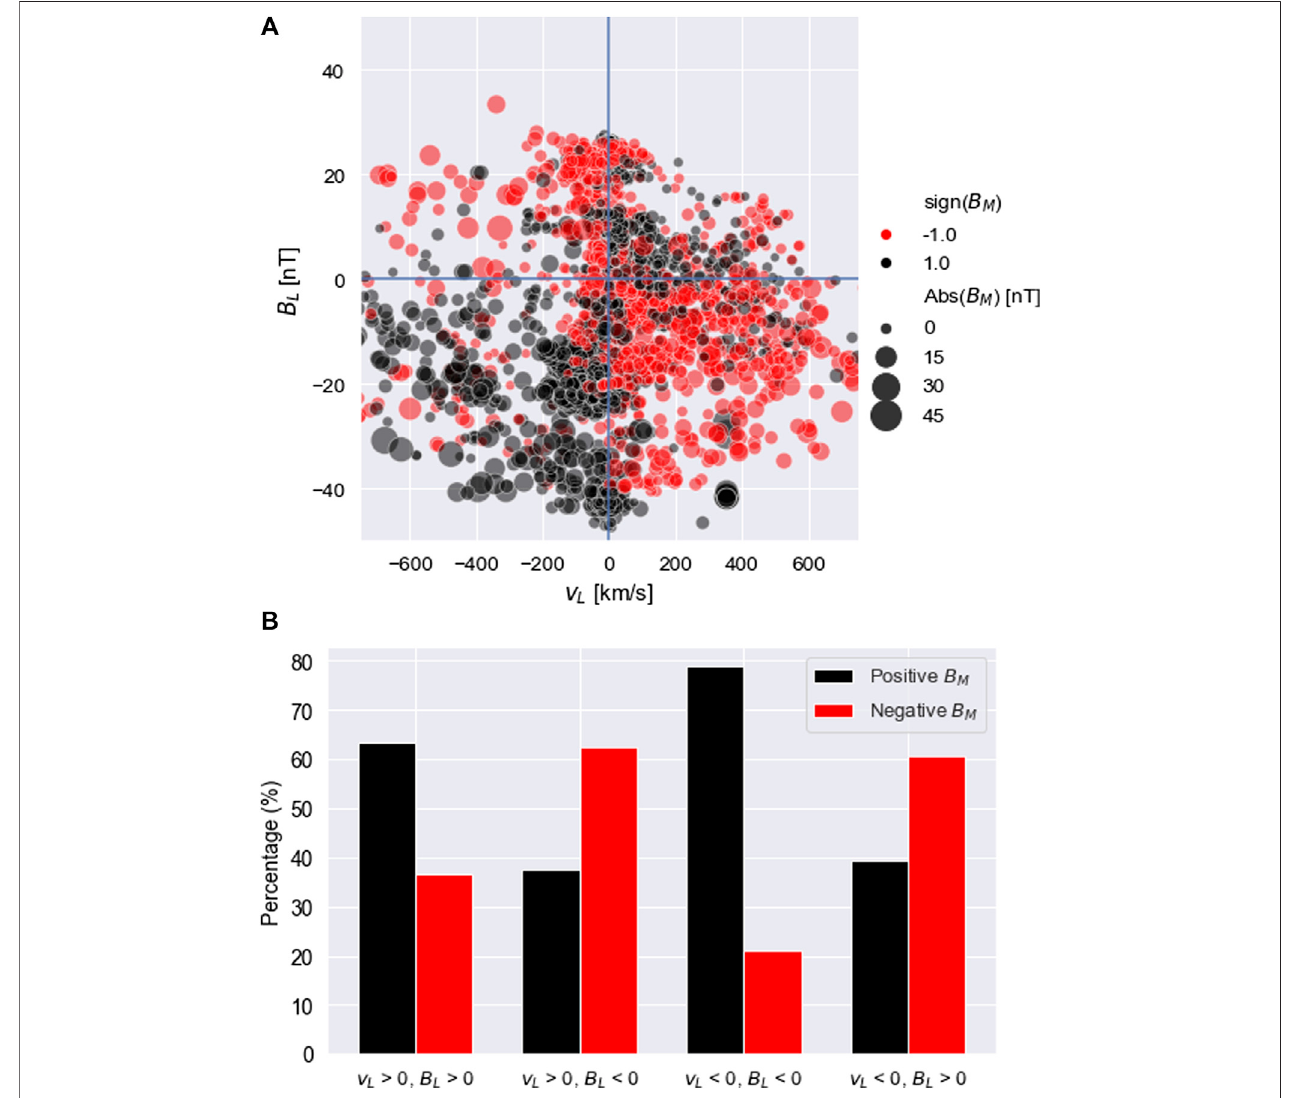
FIGURE 8 | (A) Quadrupole plot showing the out-of-plane magnetic fi eld B M in the B L - v L plane, for 10 of our observations where a reconnection signature is observed after the tearing instability distributions. The features of this plot are consistent with those seen in Figure 5 . (B) The percentage of instances with B M > 0 and B M < 0 in each